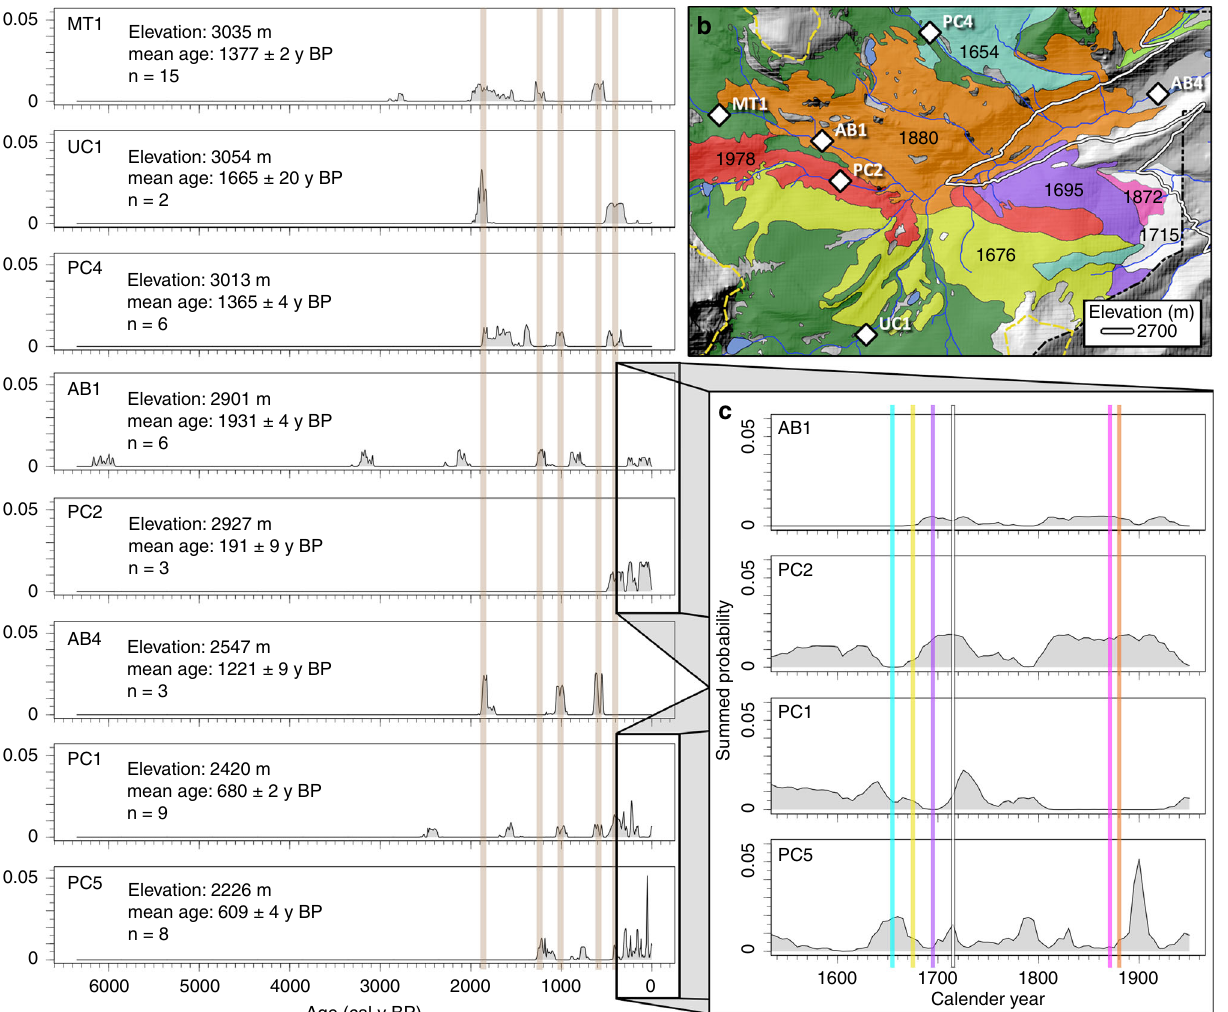
Fig. 5 Normalized summed probabilities of 14 C ages. Summed probabilities of all large charcoal radiocarbon samples from each study reach ( a ). Tan shaded areas indicate periods of interest where fi res appear to be recorded in more than one study site. The inset ( c ) displays summed probabilities of radiocarbon ages after 1500 CE compared with tree-ring dated wild fi re ages ( b ). Vertical lines in ( c ) are color-coded to match wild fi res mapped in Figs. 1b and 5b 32 . The white contour line ( b ) represents 2700 m elevation, which is the upper extent of the montane zone. White diamonds represent the location of fi eld study sites ( b ), and study sites PC1 and PC5 are located downstream from all sites in this inset. Source data are provided as a Source Data fi